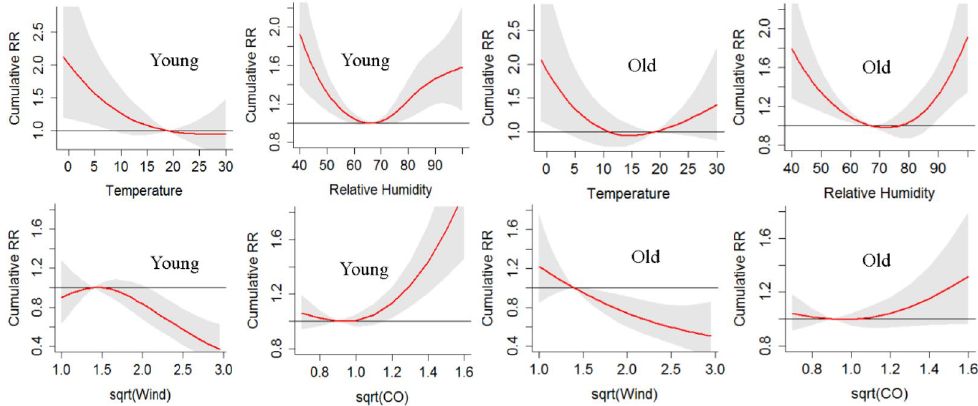
Figure 6. Plots of cumulative RR for the population with age ≤ 74 (left) and age > 74 (right): assessing the effect of